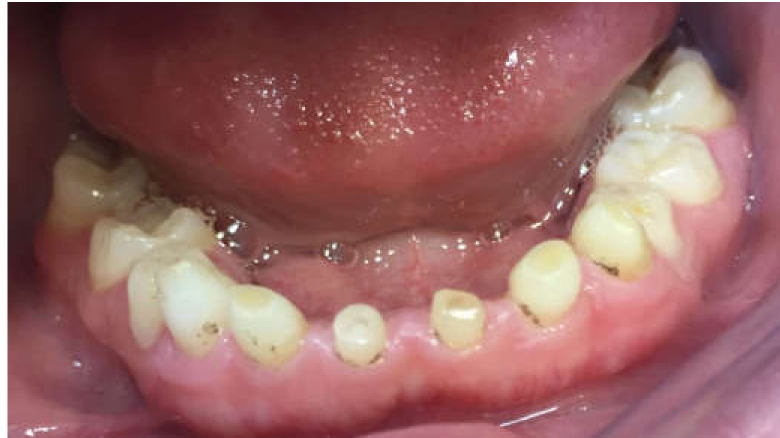
Figure 6. Seventeen-year-old boy presenting with permanent tooth